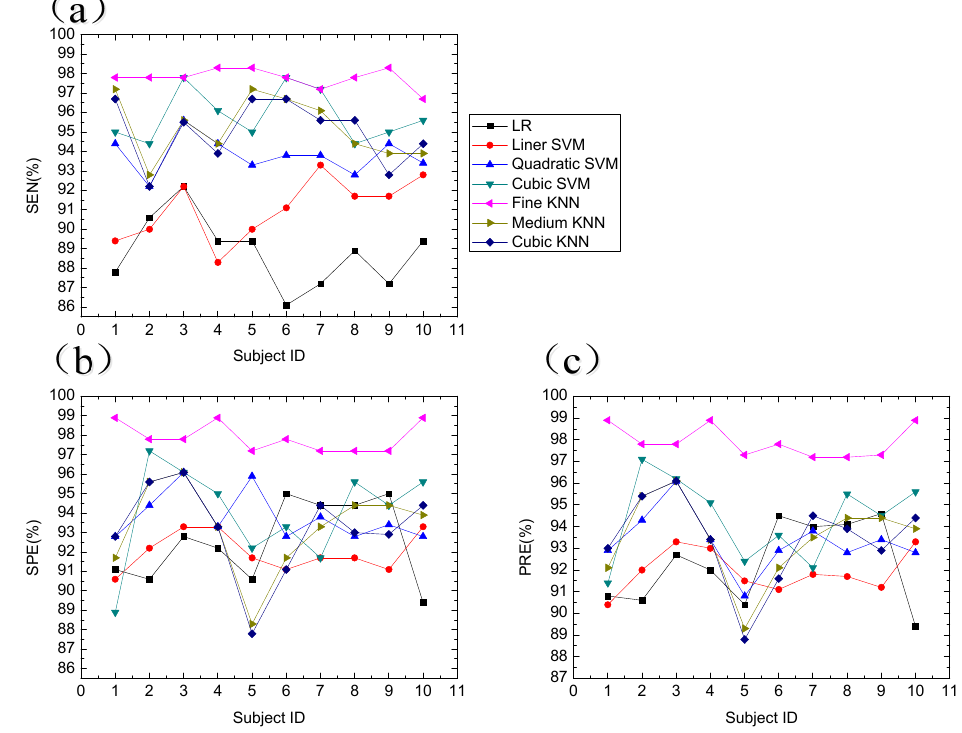
Figure 8. Performance measures of leave-one-subject-out fatigue recognition: ( a ) sensitivity; ( b ) specificity; ( c ) precision.